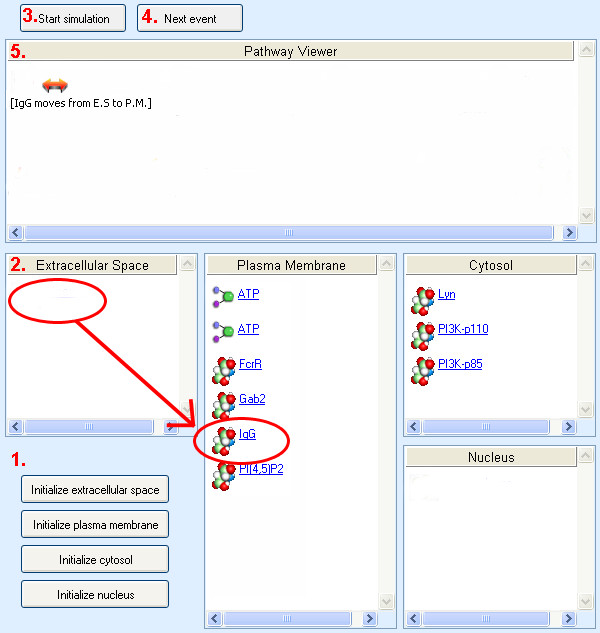
A SN- simulator: at the beginning of the simulation. The simulation showed the actions of molecules under a biological scenario. 1. The initializing buttons synthesize molecules in each subcellular compartment. 2. The localization window shows molecules present in each subcellular compartment. In this simulation, an IgG molecule was present at the extracellular space (E.S.). There were 2 ATP molecules, an Fcγ receptor (FcγR), a Gab2 and a PIP2 (PI[4,5]P2) present at the plasma membrane (P.M.). The cytosol contained a Lyn kinase, a PI3K-p85 and a PI3K-p110 subunit. There was no molecule present at the nucleus in this simulation. 3. The "Start Simulation" button creates a previously specified translocation event. In this simulation, the translocation has already occurred and moved the IgG from the extracellular space to the plasma membrane. 4. The "Next" button triggers a search that determines a proper event to occur and advances to the next step. 5. The pathway-viewer shows a series of events occurred during the simulation.